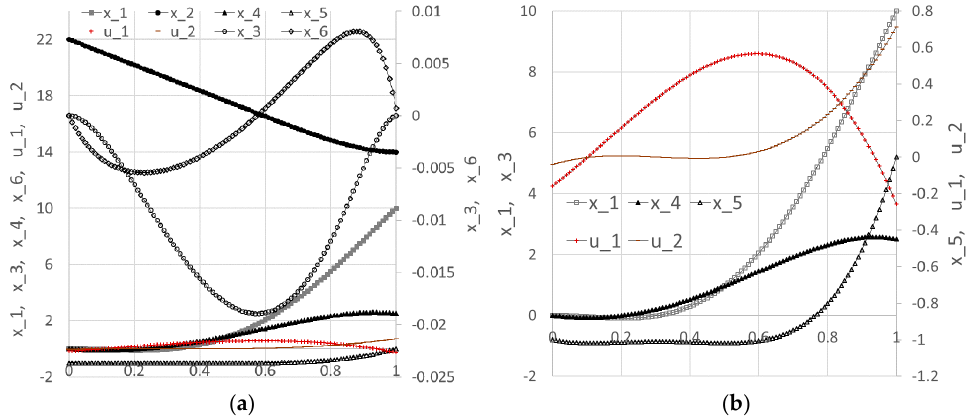
Figure 18. ( a ) Optimal trajectories for all variables of optimal control problem (17)–(29); ( b ) Selected optimal trajectories.